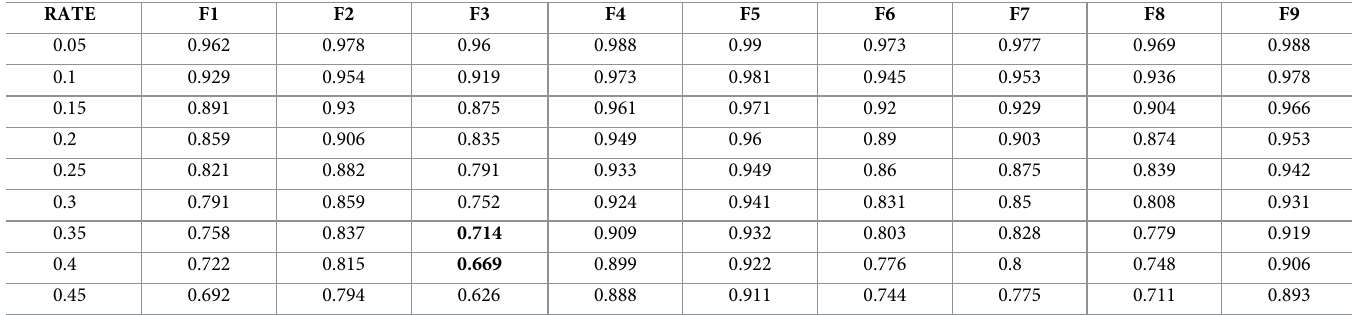
Table 12. Accuracy of Mode by